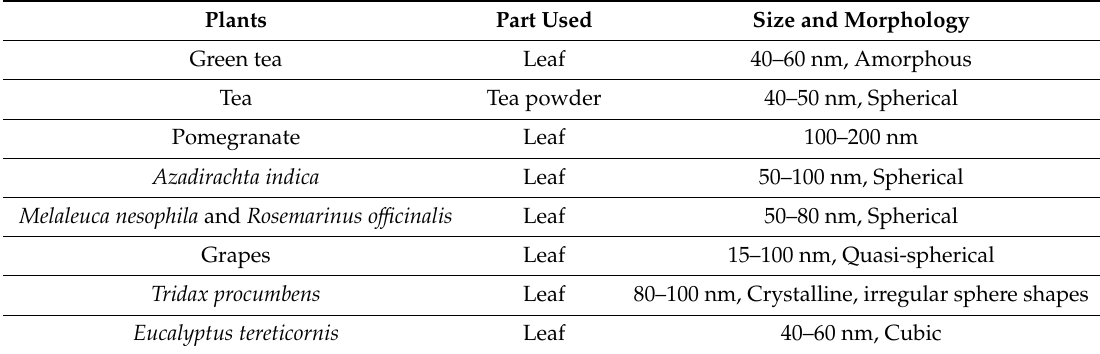
Table 4. Size and morphology of Fe 0 / Fe 2 O 3 / Fe 3 O 4 nanoparticles synthesized by various plant extracts [35].